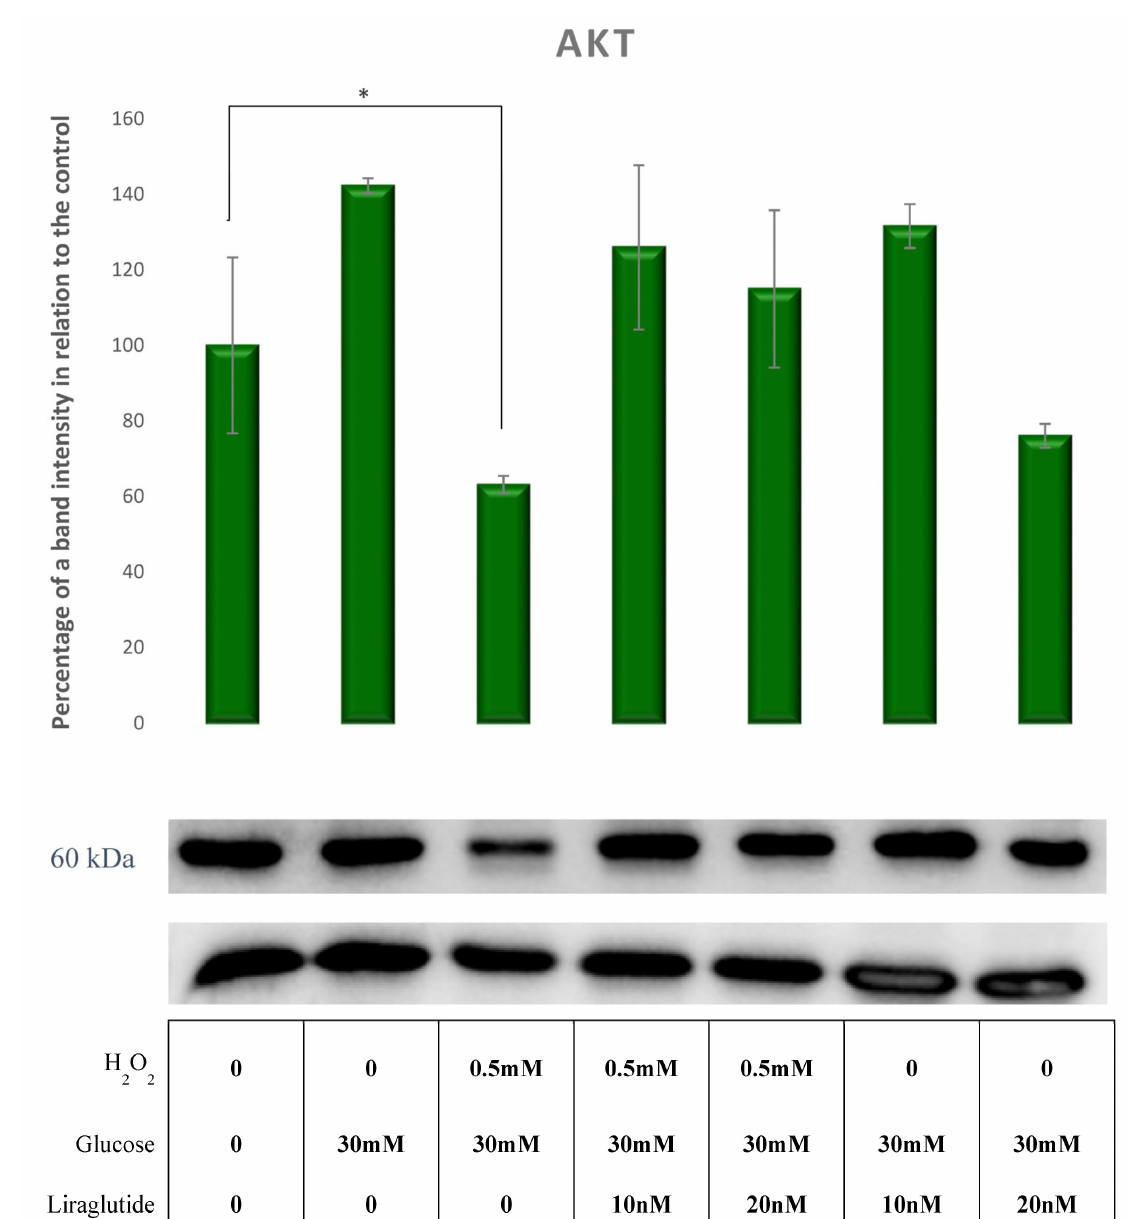
Figure 5. Protein expression in an LLC-PK1-treated cell line (control vs. HG30 and HG30/H 2 O 2 ; HG30 vs. HG30/Lira10 and HG30/Lira 20; HG30/H 2 O 2 vs. HG30/H 2 O 2 /Lira10 and HG30/H 2 O 2 /Lira 20) determined by Western blot. Glyceraldehyde 3-phosphate dehydrogenase (GAPDH) was used as an internal control. The data are shown as the means ± SD (standard deviation) from three independent biological replicates. One-way ANOVA F(6,20) = 4.04, p = 1.47 × 10 − 2 with Tukey HSD post hoc test; * p < 0.05; Values underneath the x axis represent the amount of compound added in the experiment, and 0 represents that the compound was not added. Protein expression, pig proximal tubule cell line (LLC-PK1), HG (1.5 mM, 30 mM), H 2 O 2 (0.5 mM), Liraglutide (10 nM, 20 nM). Compared to controls, there was no significant change in pAKT expression across all experimental groups, as shown in Figure